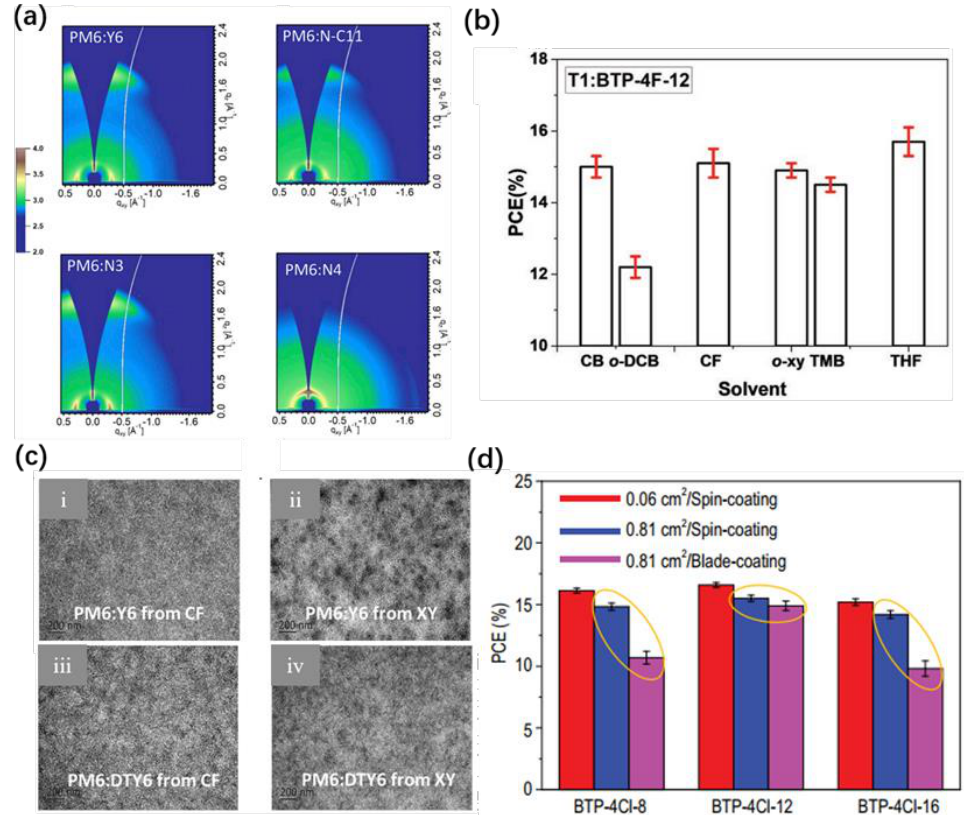
Figure 8. ( a ) 2D GIWAXS images of PM6:Y6, PM6:N-C11, PM6:N3, and PM6:N4 blend films [79]. Adapted with permission from Ref. [79]. Copyright 2019 Elsevier Inc. ( b ) Statistics of PCEs for OSCs based on T1:BTP-4F-12 with different solvents [39]. Adapted with permission from Ref. [39]. Copyright 2019 WILEY-VCH Verlag GmbH & Co. KGaA, Weinheim. ( c ) TEM images of PM6:Y6and PM6:DTY6 blend films cast from two solvents (chloroform and o-xylene) [7]. Adapted with permis- sion from Ref. [7]. Copyright 2020 Elsevier Inc. ( d ) Histogram of PCEs for BTP-4Cl-X-based OSCs under different conditions, where 0.06 cm 2 and 0.81 cm 2 are mask areas with active areas or device areas of 0.09 and 1 cm 2 , respectively [80].